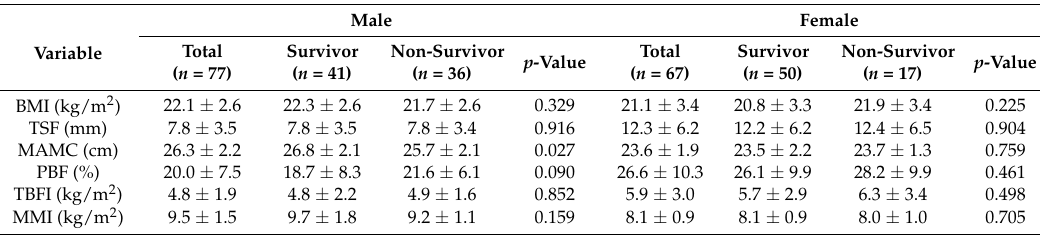
Table 2. Comparisons in the anthropometric measurements and body compositions in end-stage renal disease patients on maintenance hemodialysis according to sex.